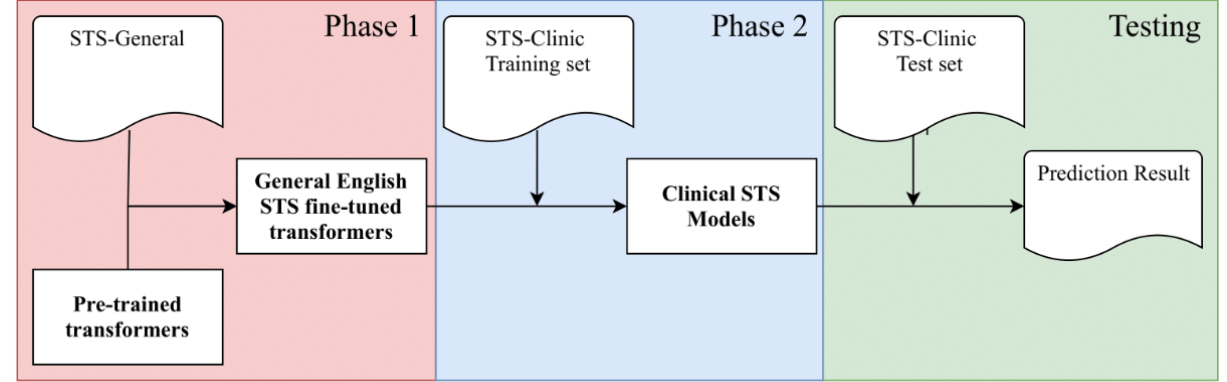
Figure 2. The two-stage procedure for clinical STS model development. STS: semantic textual similarity.